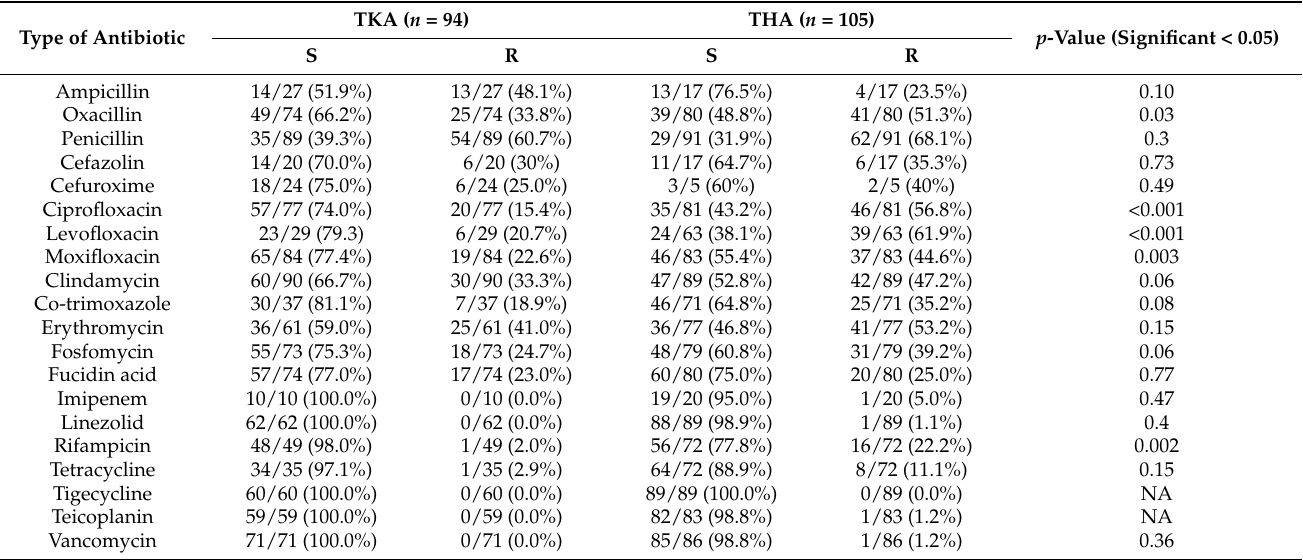
Table 3. Antibiotic resistance of 20 different types of antibiotics to Gram-positive bacteria and its statistical significance, comparing revision TKA and revision THA.